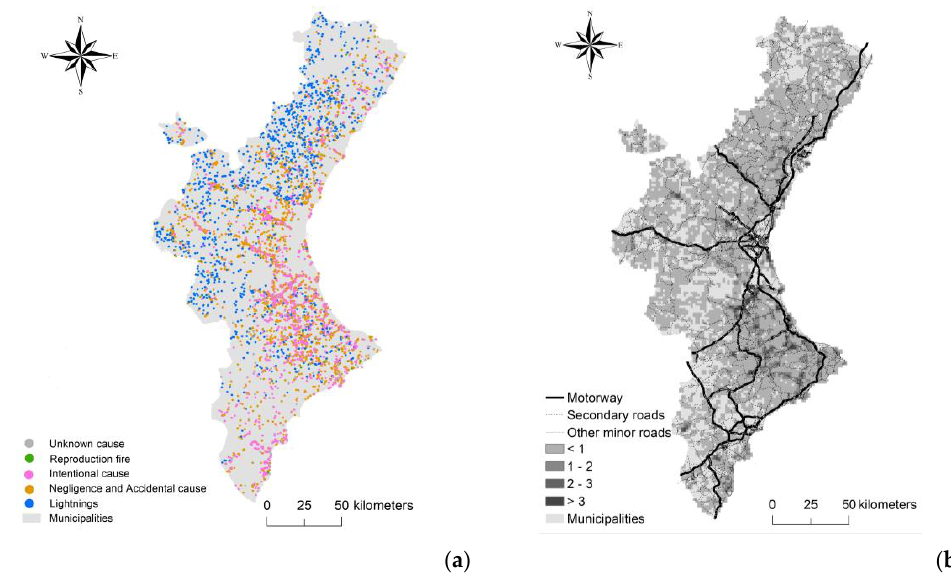
Figure 3. Spatial distribution of wildfires by type of cause ( a ) and density of the ignition points overlapped with the road system ( b ). Table 1. Road length (per cent share in total network length) by type, within a bu ff er of 0.1 and 0.5 km from the origin of the fire (i.e., ignition point) by type of